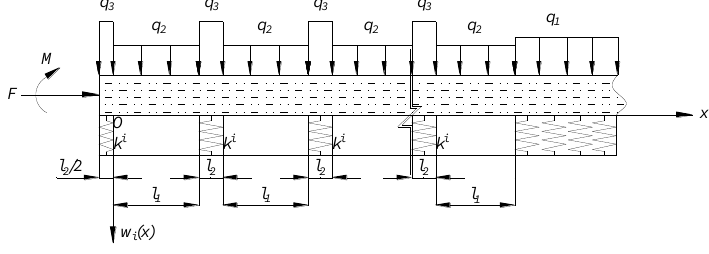
Figure 6. Mechanical model of the strata when the number of blocks was even.